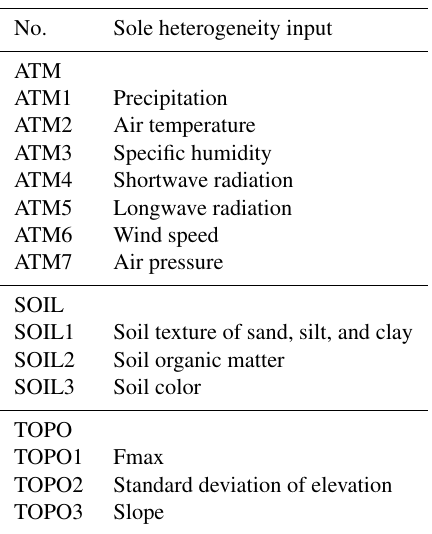
Table 3. The second set of 13 experiments with inputs from each component of the heterogeneity sources.